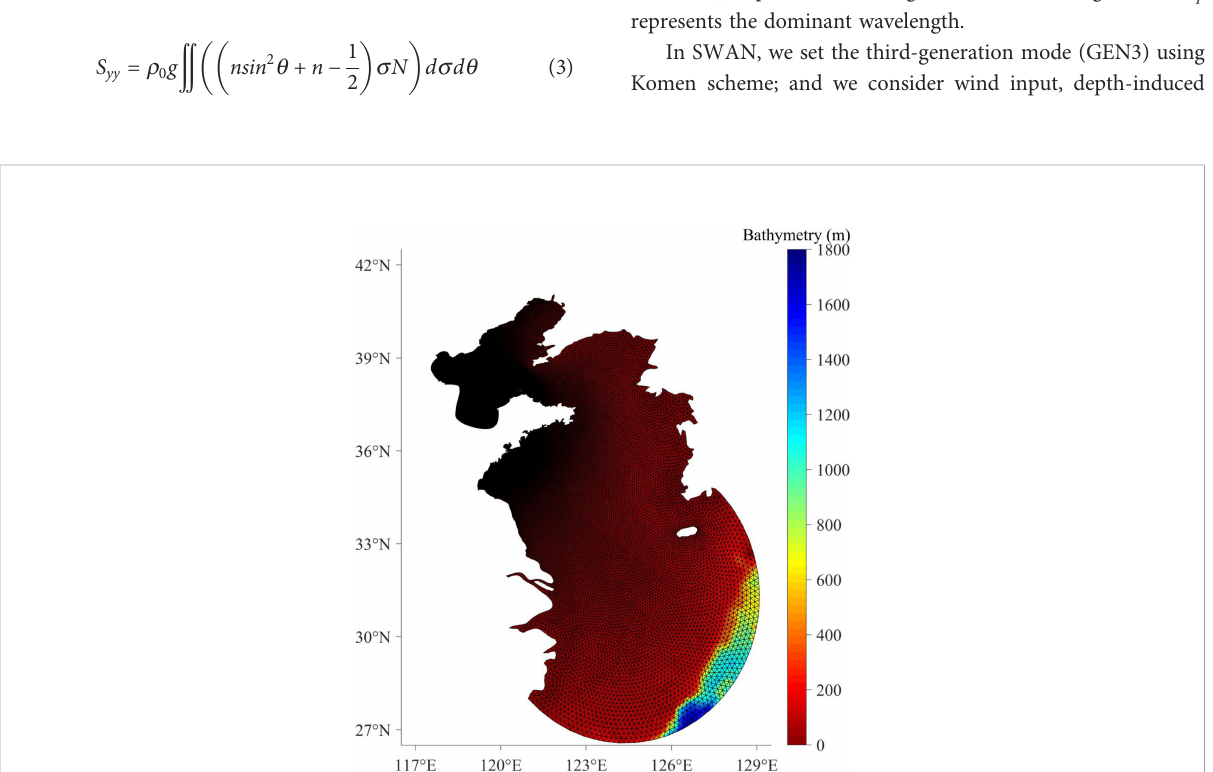
FIGURE 4 The bathymetry distribution and the total mesh including 109436 nodes and 215189 triangular elements, which possesses a resolution varying from 100 m to 20 km along the inland coastline to the open boundary; the mesh near Laizhou Bay has a resolution from 100 m to 1